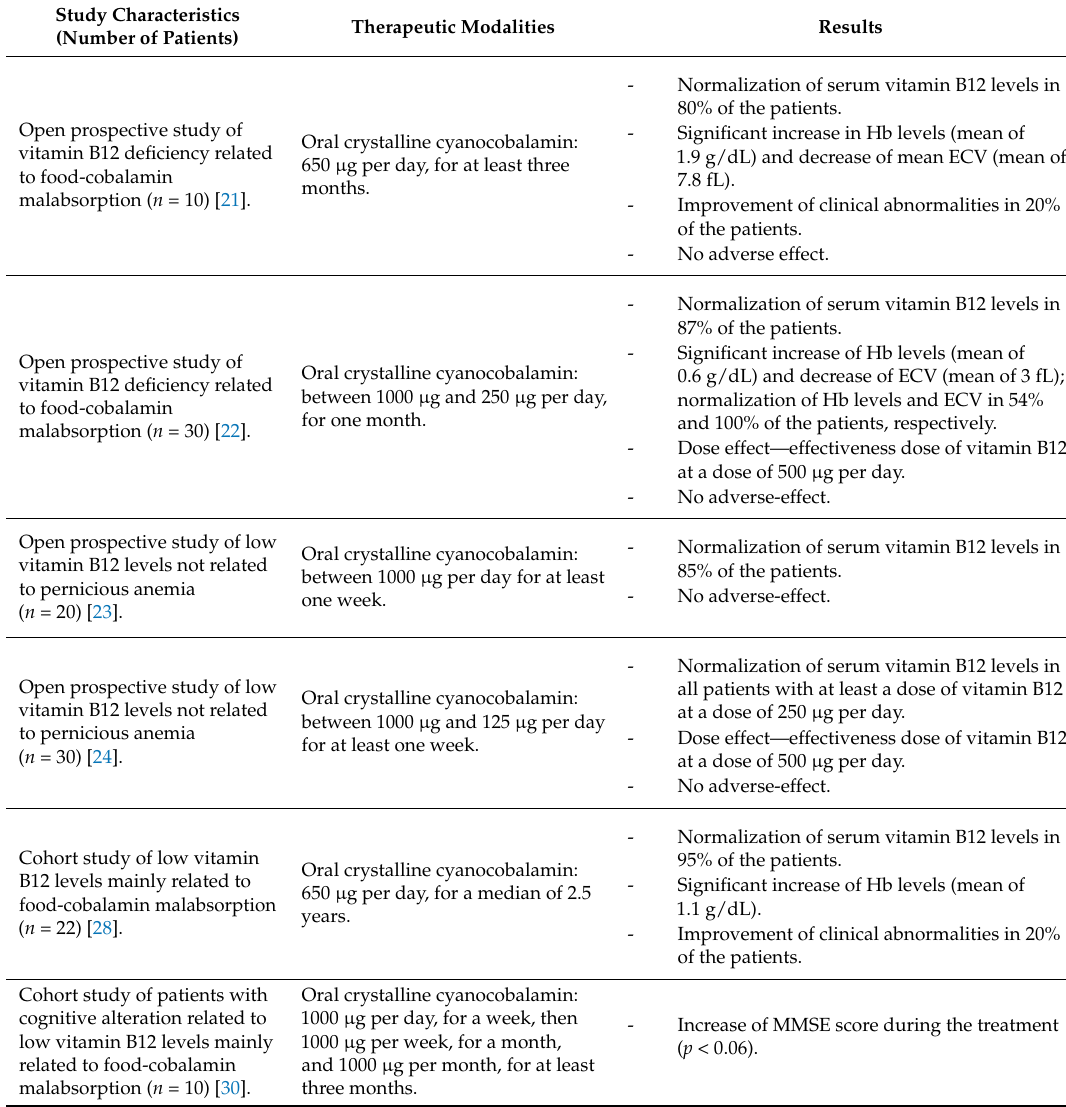
Table 2. Studies of oral vitamin B12 treatment in patients with vitamin B12 deficiency related to food-cobalamin malabsorption (maldigestion) in relation mainly with atrophic gastritis, chronic carriage and infection of Helicobacter pylori , bacterial overgrowth, long-term ingestion of antacids (e.g., proton pump inhibitors), chronic alcoholism, surgery or gastric reconstruction (e.g., bypass surgery for obesity), and partial and exocrine pancreatic insufficiency (chronic pancreatitis) (number of studies = 6). Study Characteristics Therapeutic Modalities Results (Number of Patients)